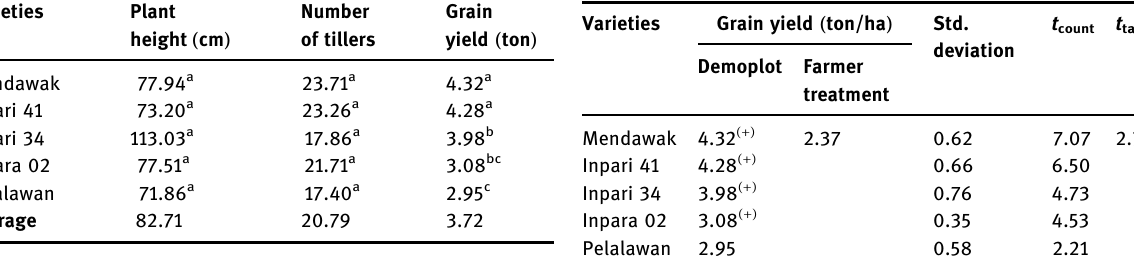
Table 7: Grain yield comparison of demoplot and farmer treatment Varieties Grain yield ( ton/ha ) Std.